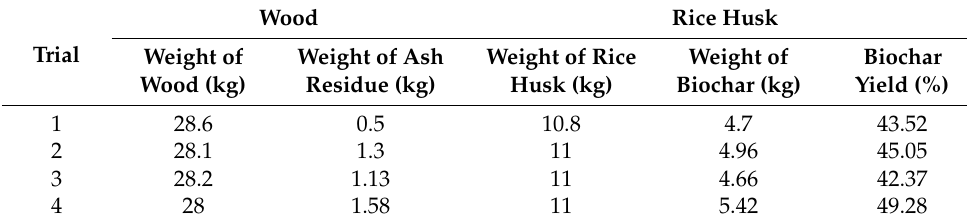
Table 4. Mass of reactants and products in the reactor and biochar yield (input and output